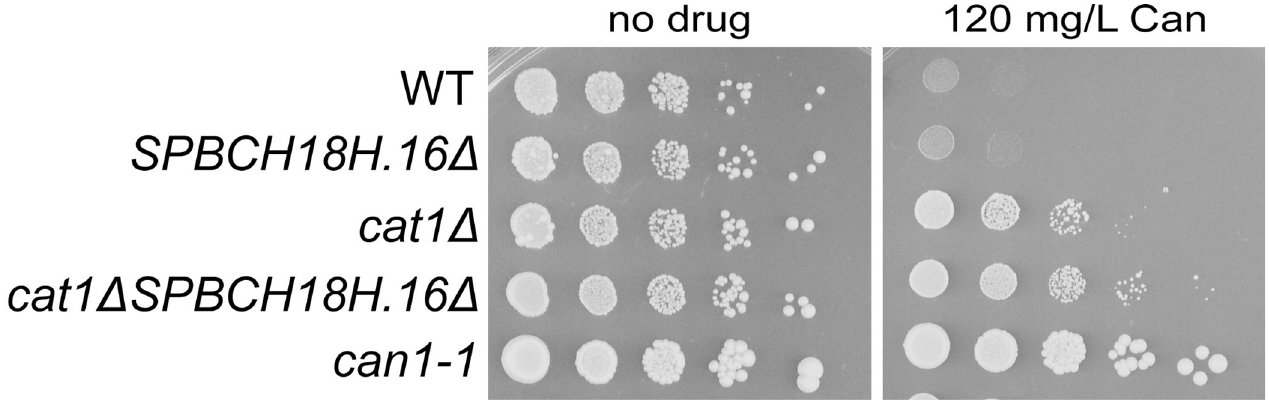
Fig 1. Canavanine resistance in cat1 and SPBC18H10 . 16 mutants. Serial 10-fold dilutions of indicated strains spotted on synthetic media (EMM) lacking arginine and containing 5 g/L of ammonium chloride in the absence or presence of canavanine (Can). The medium was supplemented with adenine, leucine and uracil. Strains used: KT1191, KT1414, KT792, KT798,